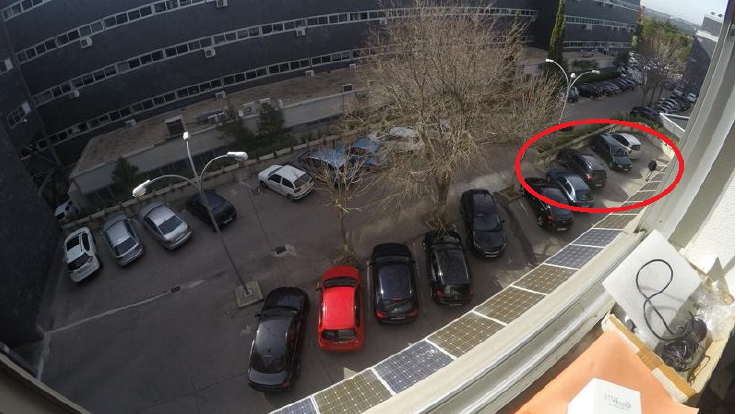
Figure 6. Example of a parking scenario of the ETSIT dataset with a lens distortion given by the camera